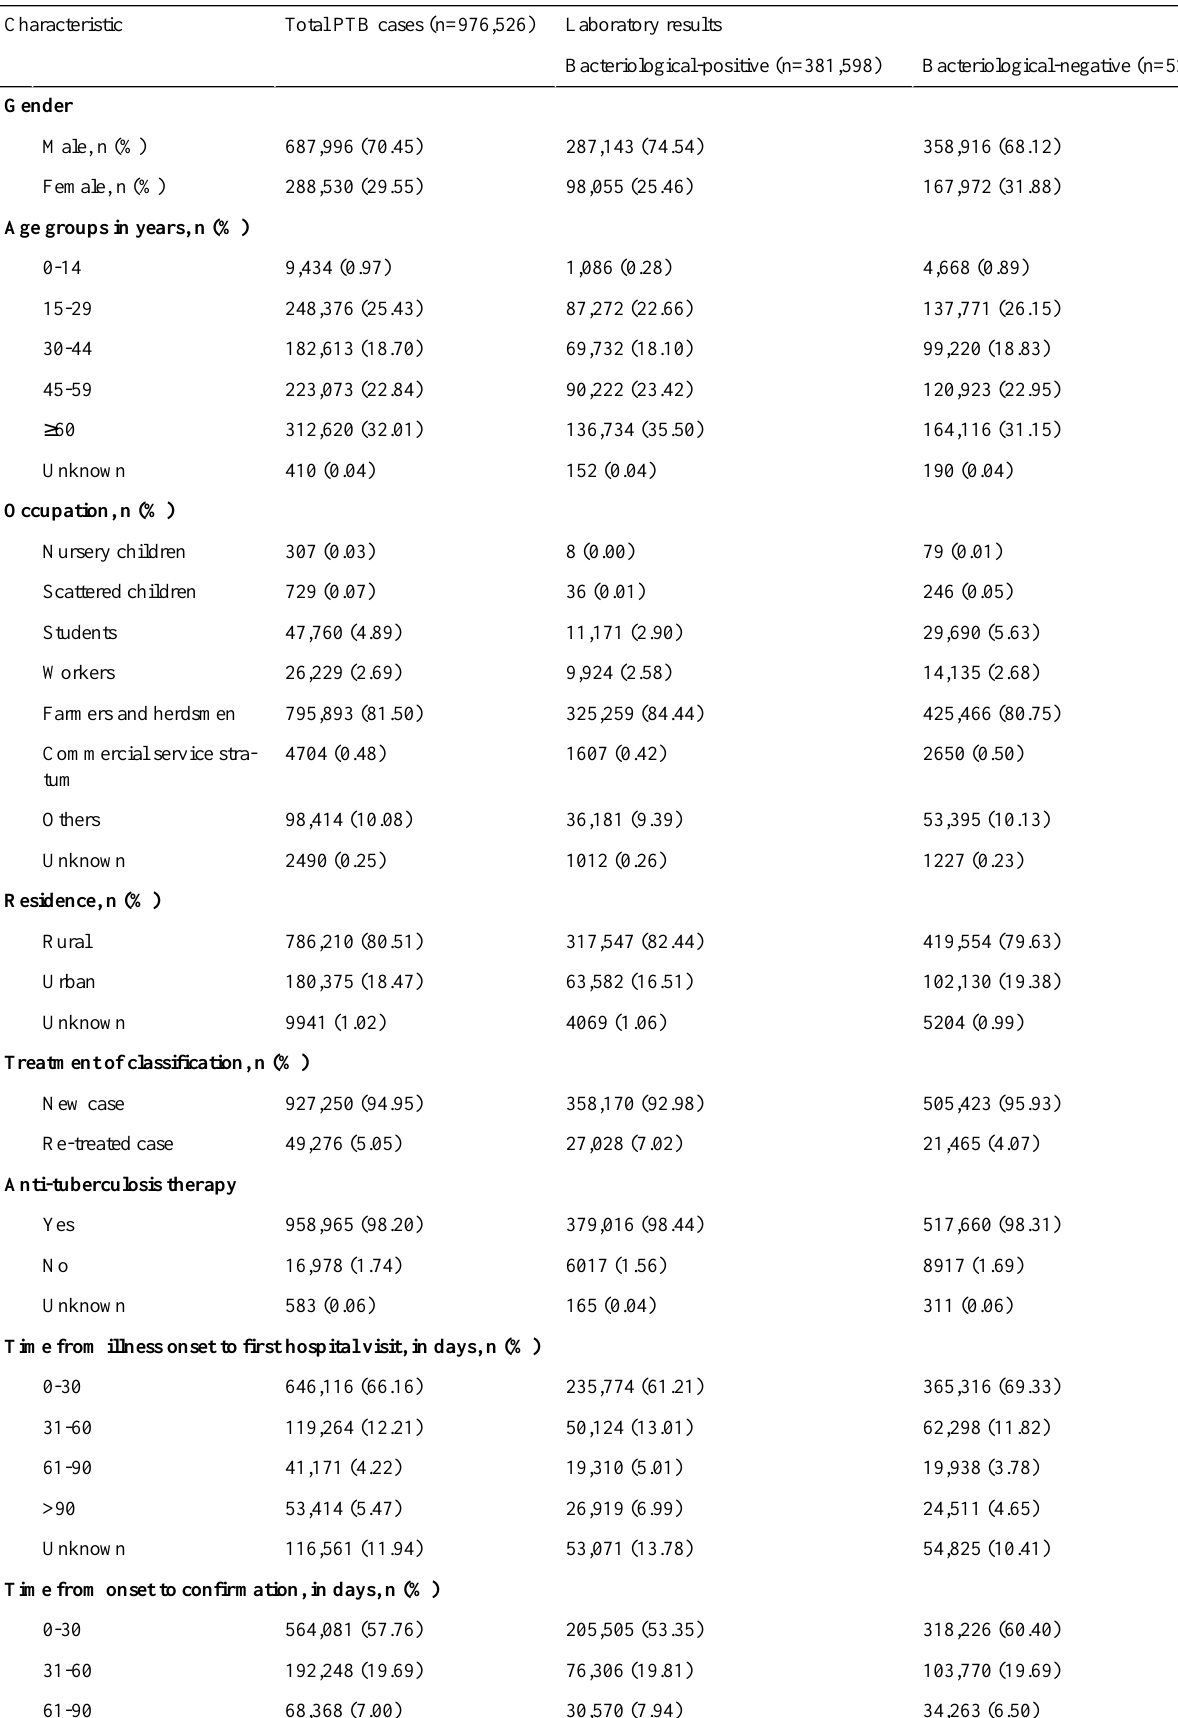
Table 1. Characteristics of pulmonary tuberculosis (PTB) cases in Henan province, China, from 2005 to